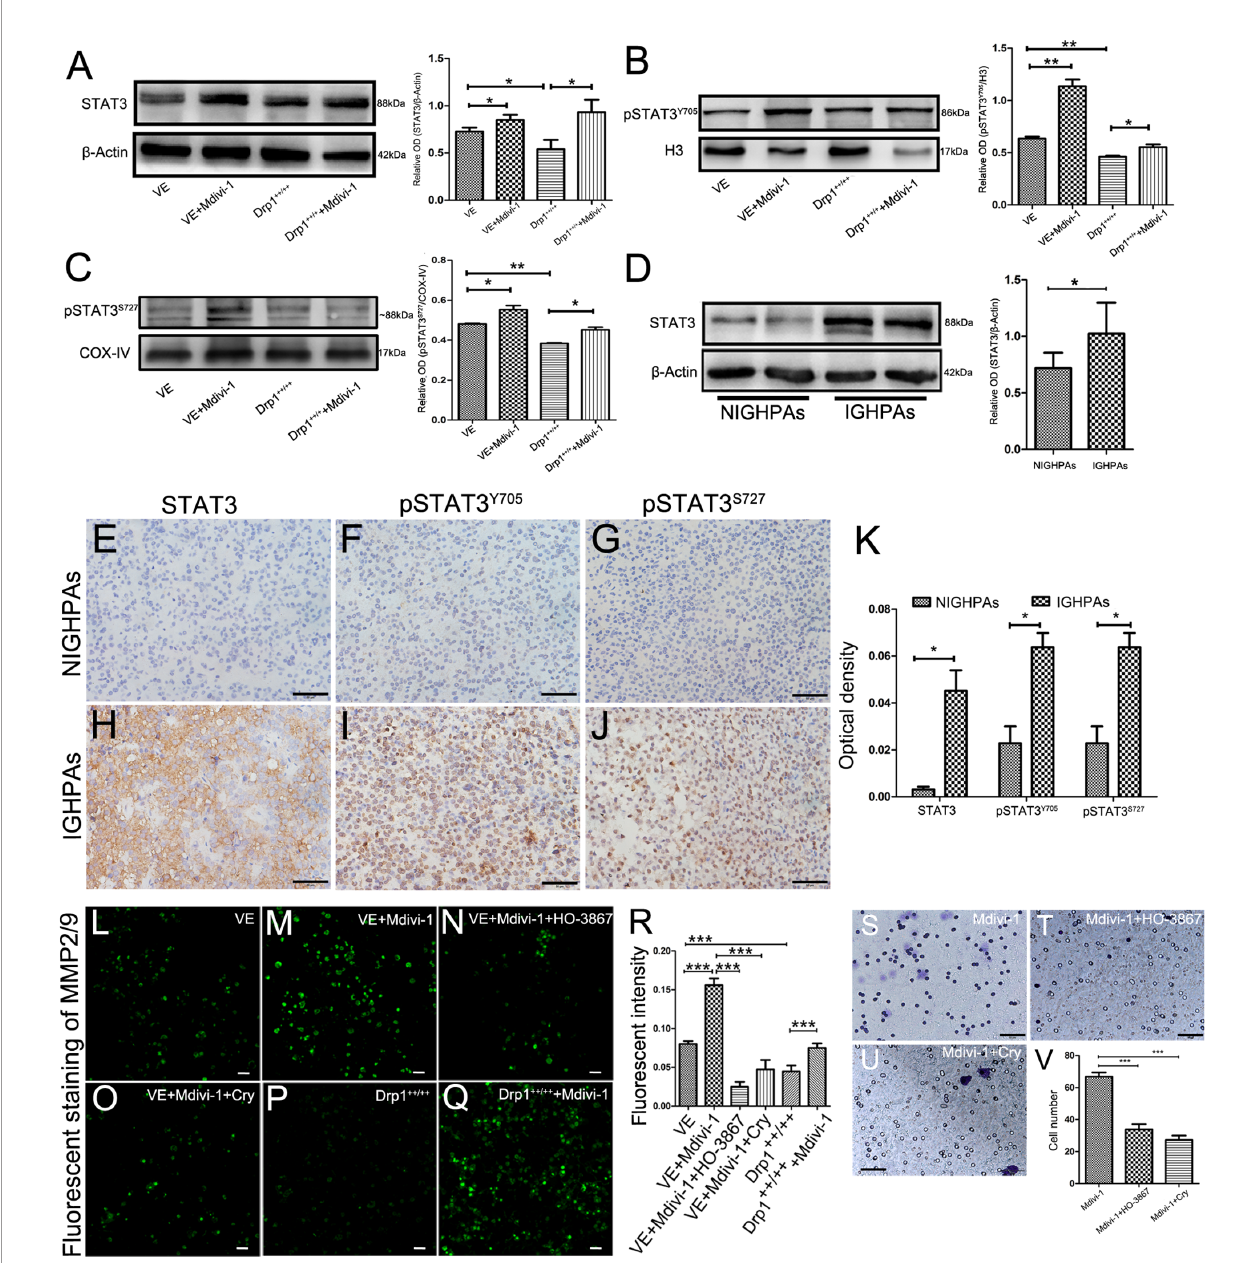
FIGURE 3 | Inhibition of Drp1 enhanced the invasion of GH3 cells via activating STAT3. (A) The expression of STAT3 protein was detected by western blotting in four GH3 cell groups (VE, VE+Mdivi-1, Drp1 ++/++ , Drp1 ++/++ +Mdivi-1) after 48 hours (n = 3) (left panel). Statistical analysis of the western blotting results (right panel). (B) Nuclear pSTAT3 Y705 , a phosphorylated form of STAT3 and mainly involved in nuclear transcription, was detected by western blotting in the four groups. H3 was used as a reference (n = 3) (left panel). Statistical analysis of the western blotting results (right panel). (C) Mitochondrial p-STAT3 S727 , another phosphorylated form of STAT3 and mainly distribute in mitochondria, was detected by western blotting in the four groups. COX-IV was used as a reference (n = 3) (left panel). Statistical analysis of the western blotting results (right panel). (D) Expression of STAT3 protein levels in NIGHPAs (n =8) and IGHPAs (n = 8) samples were assessed by western blotting (left panel). Statistical analysis of the western blotting results (right panel). (E – G) IHC staining of STAT3, pSTAT3 Y705 , pSTAT3 S727 in NIGHPAs samples (n = 10). (H – J) IHC staining of STAT3, pSTAT3 Y705 , pSTAT3 S727 in IGHPAs samples (n = 10). (K) Statistical analysis of the IHC results. (L – Q) Activity of MMP2/9 were detected by situ zymography fl uorescence staining in six groups (VE, VE+Mdivi-1, VE+Mdivi-1+HO-3867, VE+Mdivi-1+Cry, Drp1 ++/++ , Drp1 ++/++ +Mdivi-1). (R) Statistical analysis of the MMP2/9 fl uorescent intensity. (S – U) GH3 cell invasion were evaluated by transwell assay when treated with Mdivi-1, Mdivi-1+HO-3867, Mdivi-1+Cry. (V) Statistical analysis of the invasive GH3 cell number in the three groups. HO-3867, a broad spectrum inhibitor of STAT3 phosphorylation. Cry, a selective inhibitor of STAT3 phosphorylation at Tyr705. (E – J, S-U) , Scale bar =50 m m. L-Q, Scale bar =25 m m. *P < 0.05, **P < 0.01, ***P < 0.001. Data were expressed as mean ±